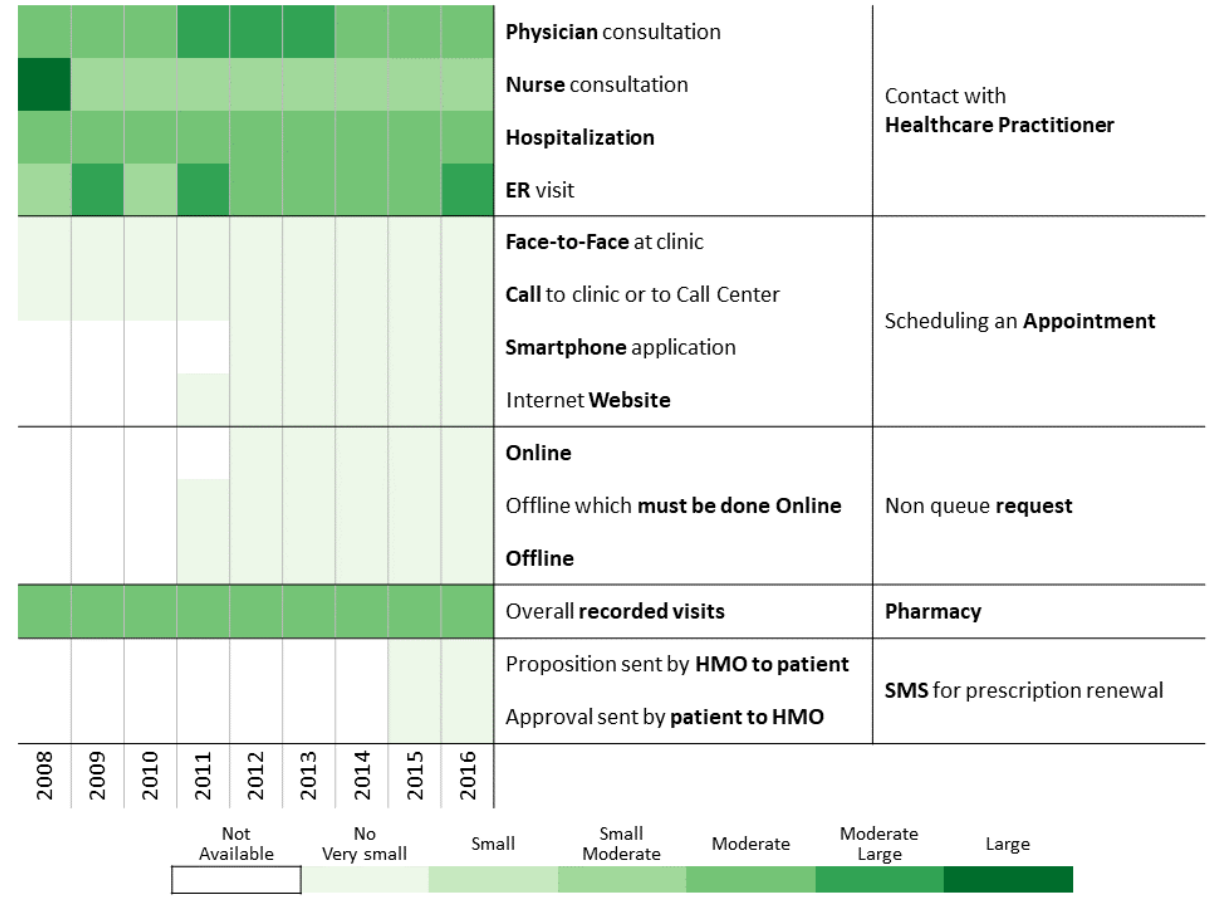
Figure 11. Communication patterns for patients having measured human contacts without generally scheduling their